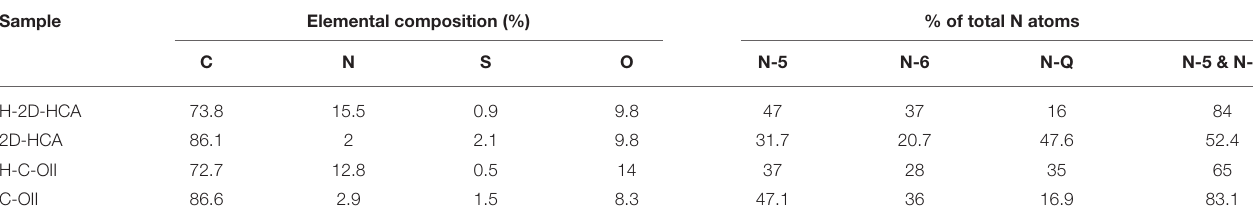
TABLE 1 | Surface physiochemical properties of various samples by XPS tests.